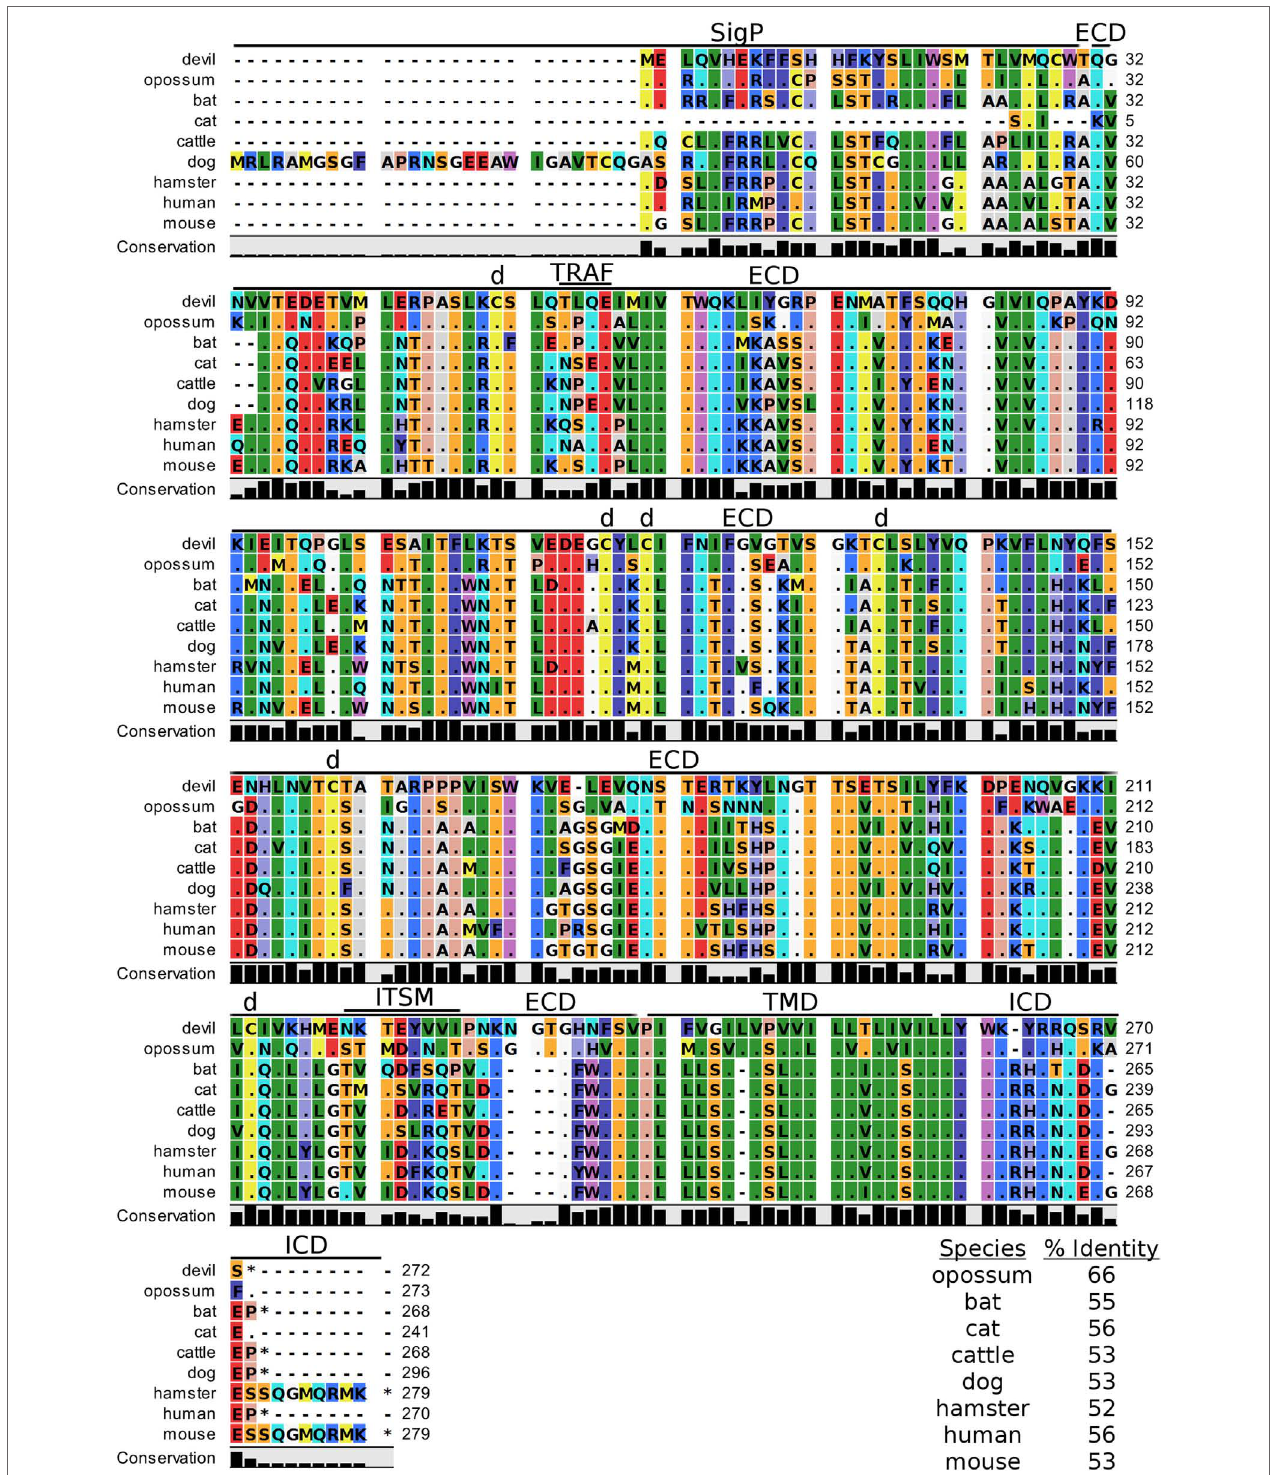
FigUre 9 | alignment of cD200 reference genes for nine species . The predicted signal peptides (SigP), extracellular domain (ECD), transmembrane domain (TMD), and intracellular domain (ICD) are demarcated with bars. “d” above the alignment represents predicted disulfide bonds. “TRAF” indicates a potential TRAF1/2-binding site and “ITSM” represents a putative immunoreceptor tyrosine-based switch motif (ITSM). The black bar graphs below the alignment represent the conservation of amino acids across all nine species. The percent amino acid sequence identity between devils and other species is shown in the bottom right corner of the